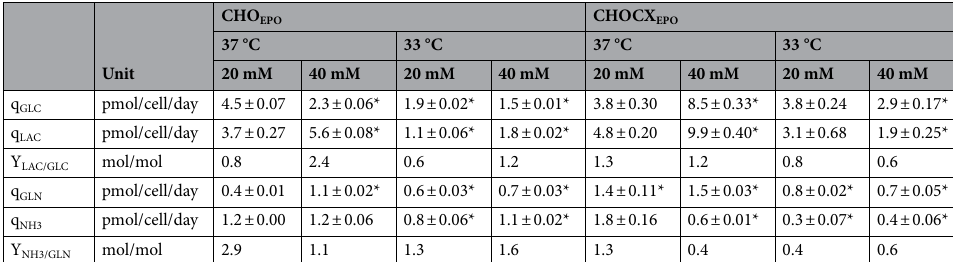
Table 1. Metabolic parameters of the CHO EPO and CHOCX EPO at different culture temperatures (37 and 33 °C) and initial glucose concentrations (20 and 40 mM). (*) indicates p -values ( t -test) below 0.05 (Culture of CHO EPO at 37 °C and 20 mM glucose was the control